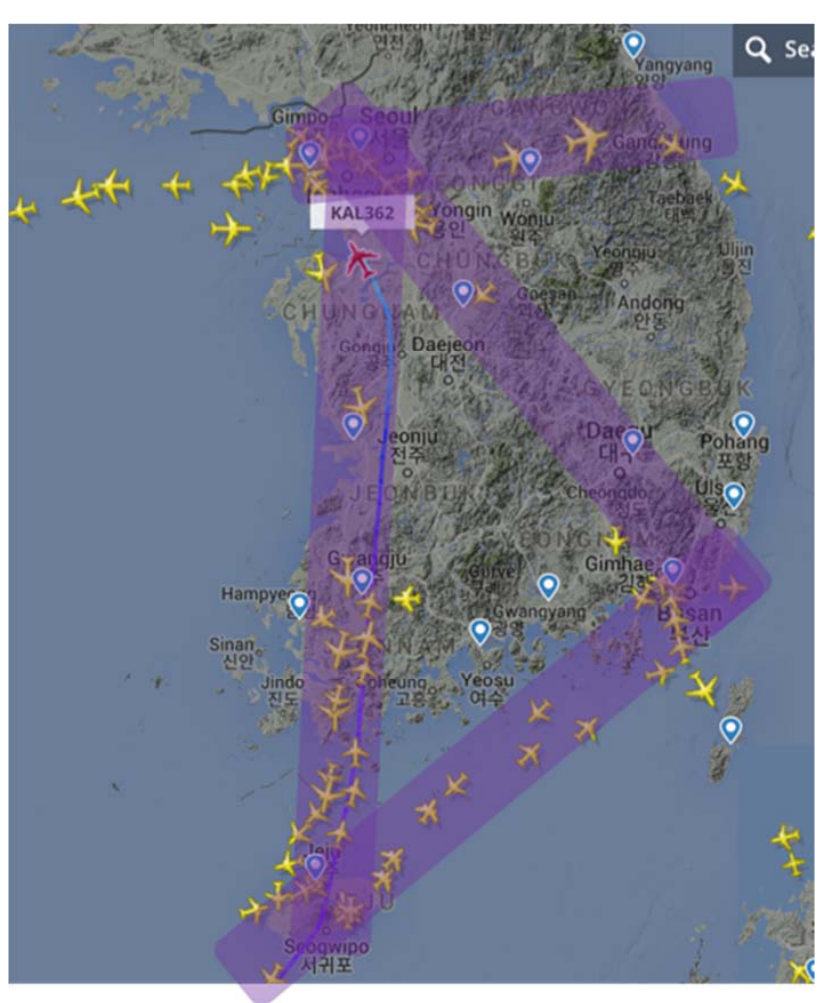
Figure 19. Heavy air traffic routes in South Korea are represented as shaded regions.